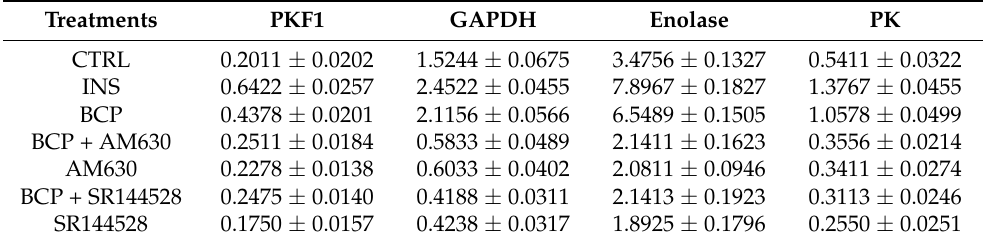
Table 1. Trans- β -Caryophyllene (BCP) effects on glycolytic pathway.